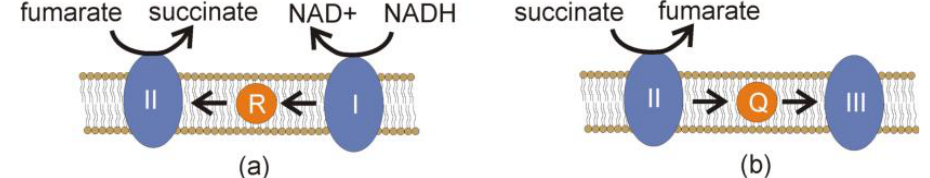
Figure 4. The use of ubiquinone and rhodoquinone in electron transport. ( a ) As part of the reductive branch of malate dismutation under anaerobic conditions, NADH is oxidized to NAD + by complex I